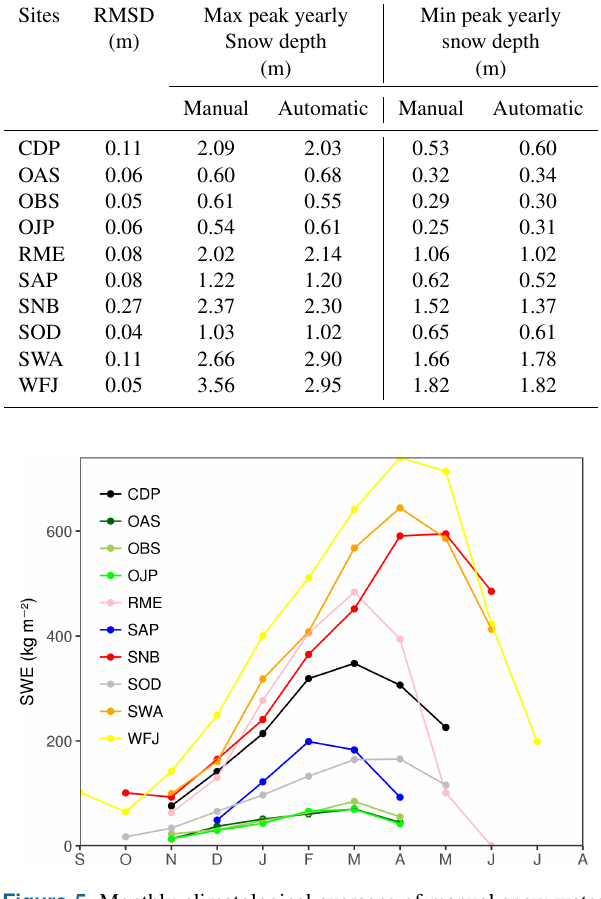
Figure 5. Monthly climatological averages of manual snow water equivalent measurements.